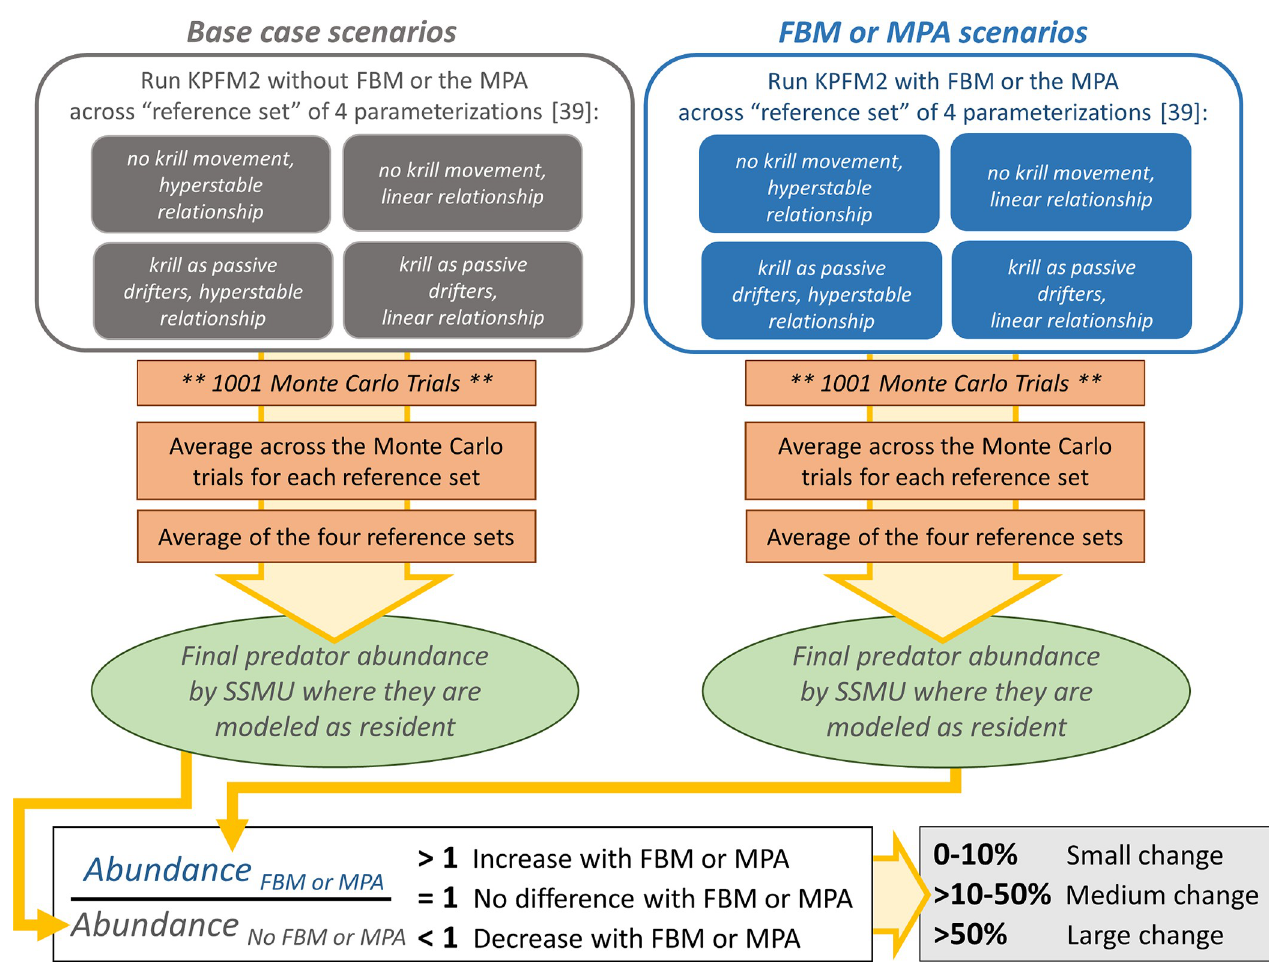
Fig 2. Schematic of the modelling process. For both the ‘base case’ (left column, top grey boxes) and FBM or MPA (right column, top blue boxes) scenarios, the model is run across all four parameterizations (top boxes) and across 1001 Monte Carlo trials. These are then averaged for final results (green circle), and the relative change assessed (bottom row of